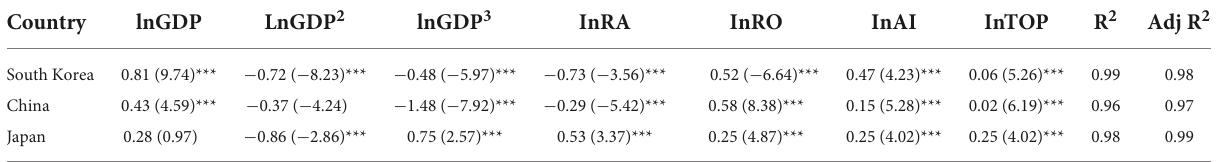
TABLE 6 Country-wise results estimated by FMOLS, InCO2 = f (InGDP, InGDP2, InGDP3, InRA, InRO, InAI, and InTOP).